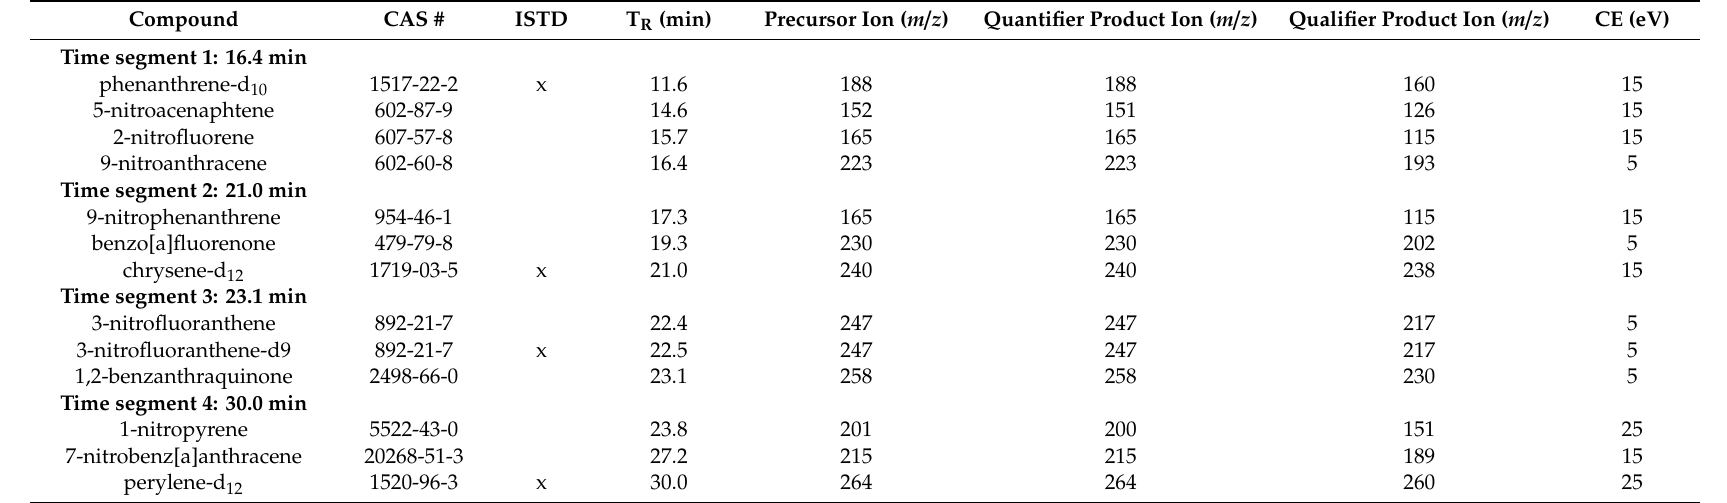
Table 2. List of nitro- and oxy-PAHs and ISTD. MRM acquisition parameters: time segments, retention times (TR, min), precursor ions, quantifier and qualifier ions, collision energy (CE, eV). CAS numbers are also